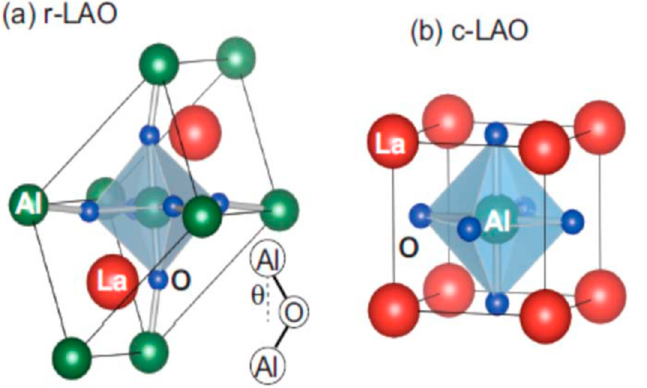
Figure 5. Crystal structures of LaAlO 3 perovskite: ( a ) rhombohedral (r-LaAO) and ( b ) cubic (c-LaAlO) (Reprinted with permission from [29]).